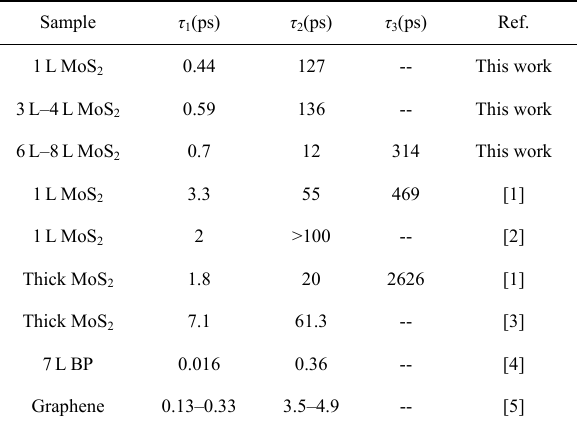
Table 2 Comparison of the dynamic decay time in different materials.